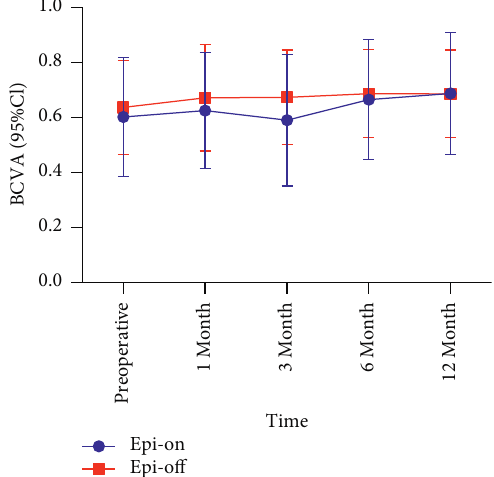
Figure 1: Comparison of the BCVA during the 12-month follow- up period. BCVA: Best-corrected visual acuity; CI: confidence